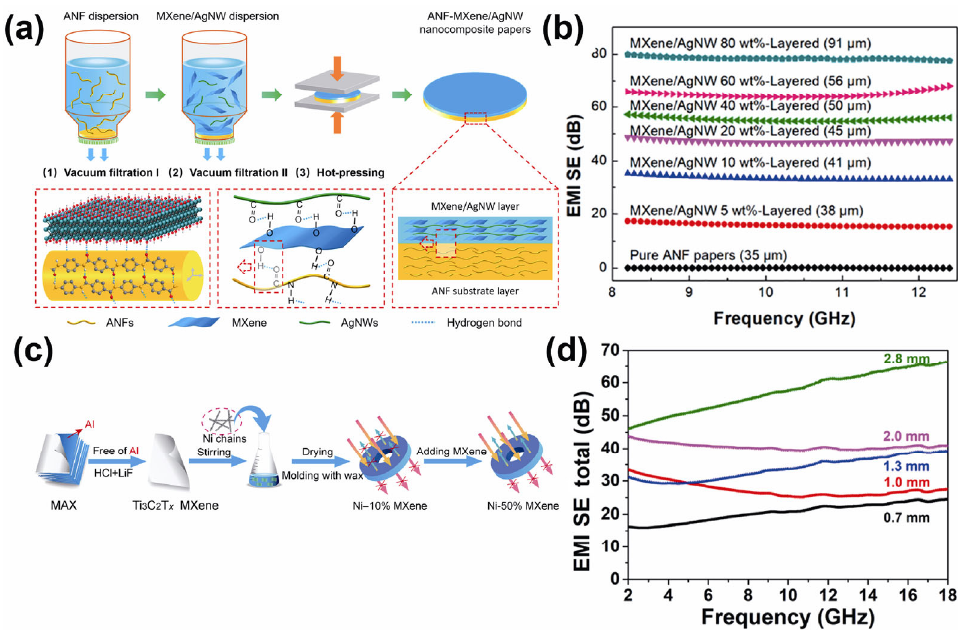
Fig. 27 (a) Illustration of the fabrication for ANF-MXene/AgNW nanocomposite papers. (b) EMI SE of ANF-MXene/AgNW nanocomposite and pure ANF paper. Reproduced with permission from Ref. [249], © American Chemical Society 2020. (c) Illustration of the fabrication of MXene/Ni hybrids. (d) The EMI SE total curve of Ni–50% MXene with different thicknesses. Reproduced with permission from Ref. [250], © American Chemical Society